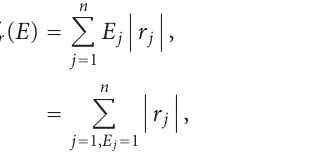
Figure 3: Basic structure of